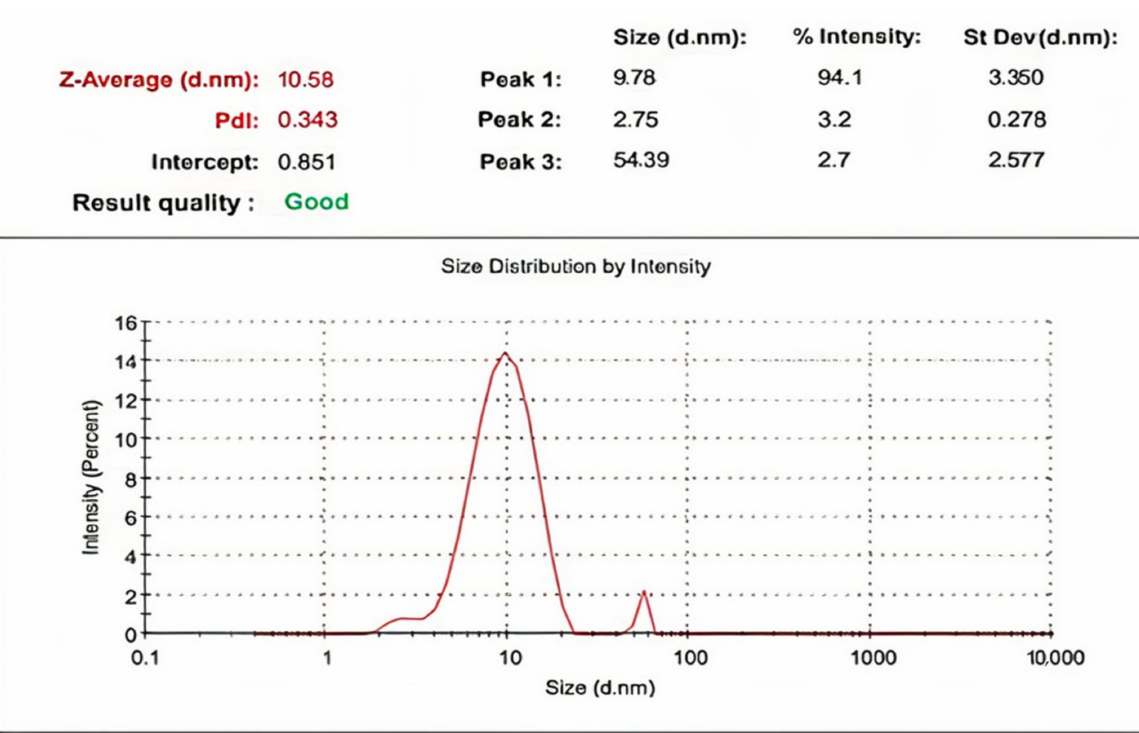
Figure 5. FTIR spectrum of the alcoholic extract of the aerial parts of P. auriculate .